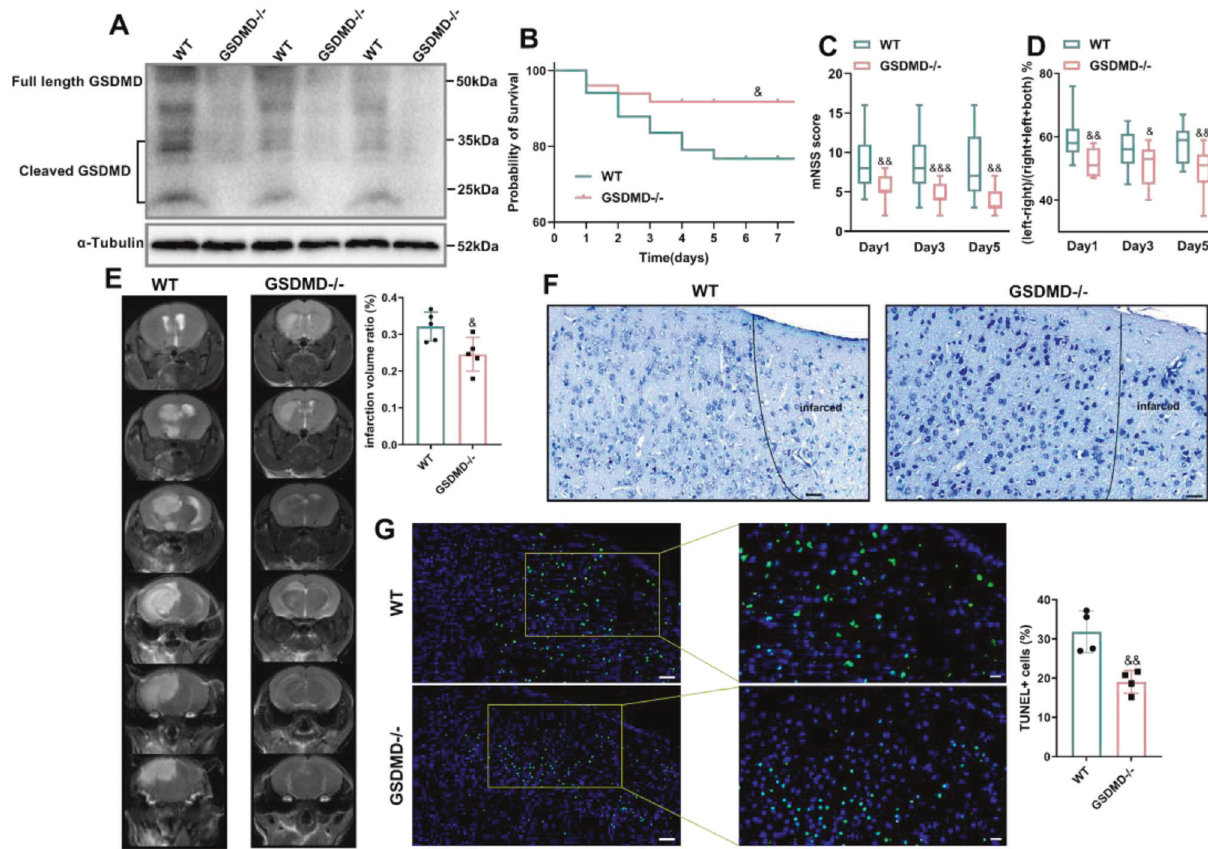
Fig. 2 GSDMD de fi ciency mitigates brain damage caused by MCAO. A Western blot analysis of GSDMD protein expression in the brain tissue of GSDMD − / − mice compared to WT mice ( n = 3). B Kaplan – Meier survival curves comparing post-MCAO survival of WT mice ( n = 35) to that of GSDMD − / − mice ( n = 50). GSDMD de fi ciency improved neurological functions, as indicated by the mNSS ( n = 15) ( C ) and cylinder test ( n = 13) ( D ). E Representative magnetic resonance imaging and quantitative analysis of the infarcted brain on 3 days after stroke